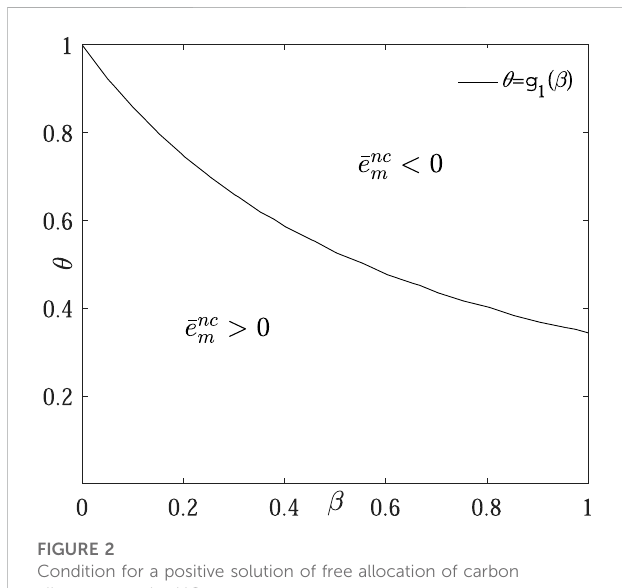
FIGURE 2 Condition for a positive solution of free allocation of carbon allowance under